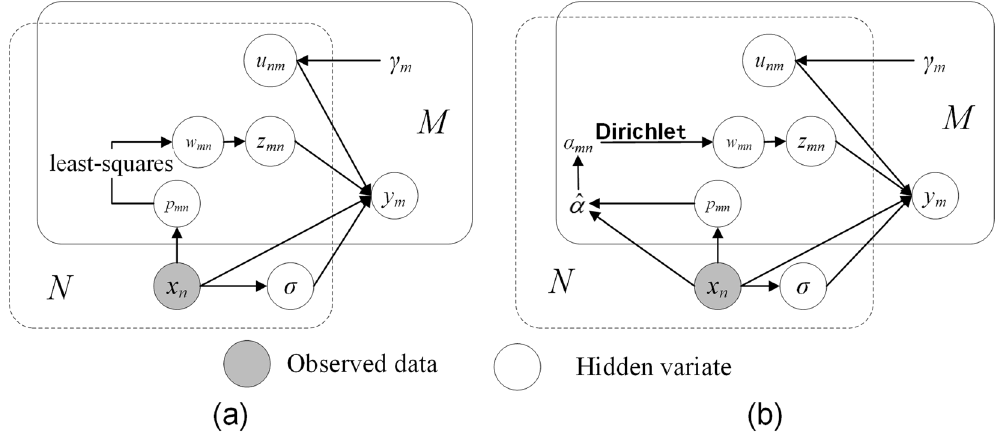
Figure 1. Representation of the Student’s-t mixture model with Dirichlet distribution as a directed graphical model. The M -box denotes the M observations x m , and the N -box denotes the N mixture components. Note that the random variable u mn , w mn , and z mn belong to both M -box and N -box, indicating that they are corresponding random variables for the Student’s-t mixture components and the observations. ( a ) pSMM for point set registration, ( b ) DSMM for point set